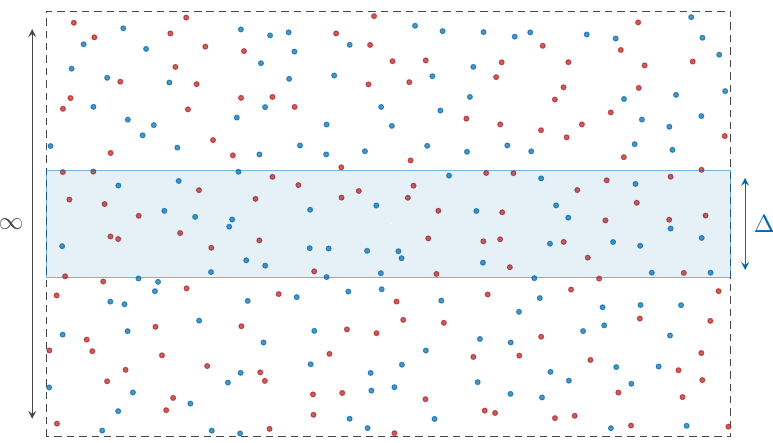
Figure 1. A schematic representation of the dilute instanton gas approximation. The e(cid:11)ective potential is a collective e(cid:11)ort of all types of instanton con(cid:12)gurations at all times. We expect that this collective e(cid:11)ort is diminished at short times, as highly wound, widely-separated con(cid:12)gurations cannot \(cid:12)t" into the time interval (cid:1) t